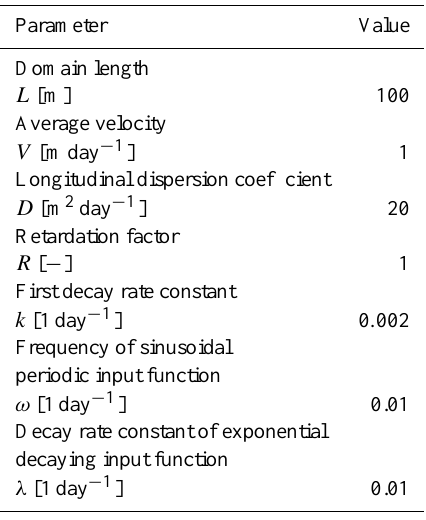
Fig. 1 Fig. 1. Comparison of the breakthrough curves at x = 100m ob- tained from the developed specific analytical solution for sinu- soidally periodic input function ( f (t) = 1 + sin t) and the corre- sponding numerical solution.